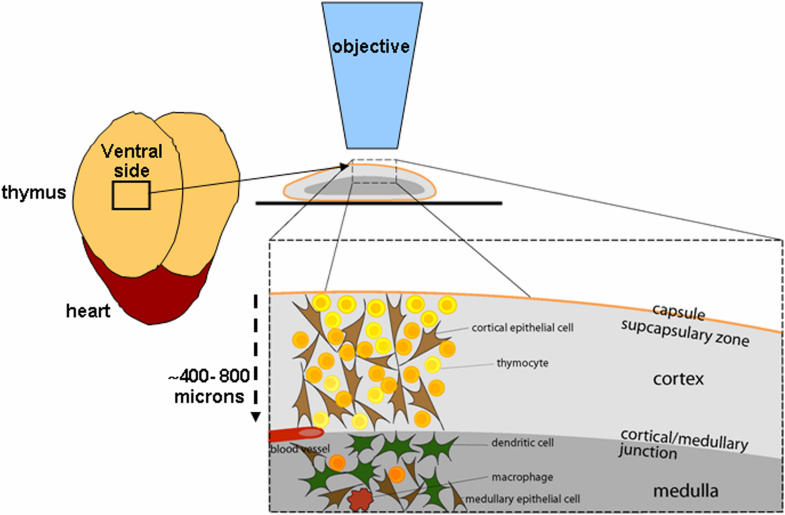
Real-time visualization of thymocytes within intact thymic lobes using two-photon microscopy